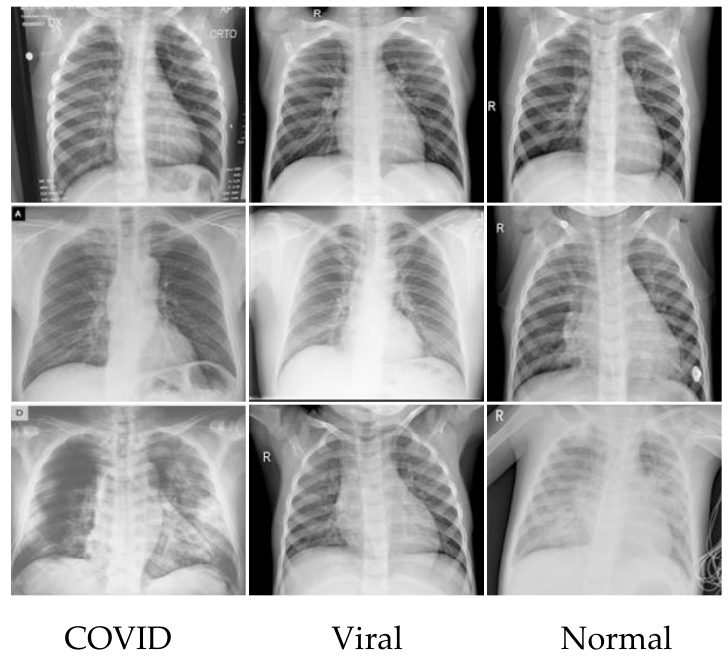
Figure 2. The partial CXR images of the COVID-19 Radiography database.